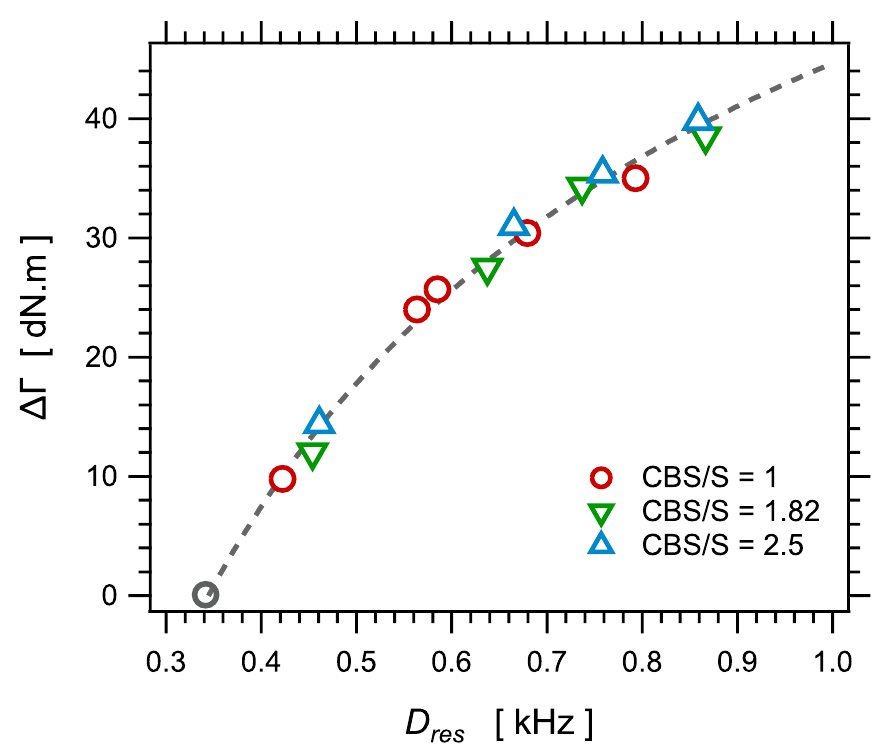
Figure 8. The torque increase ∆Γ during curing as a function of the NMR parameter D res , for the series of samples with different amounts of sulfur and different sulfur/accelerator ratios. The dashed curve is a guide for the eye.